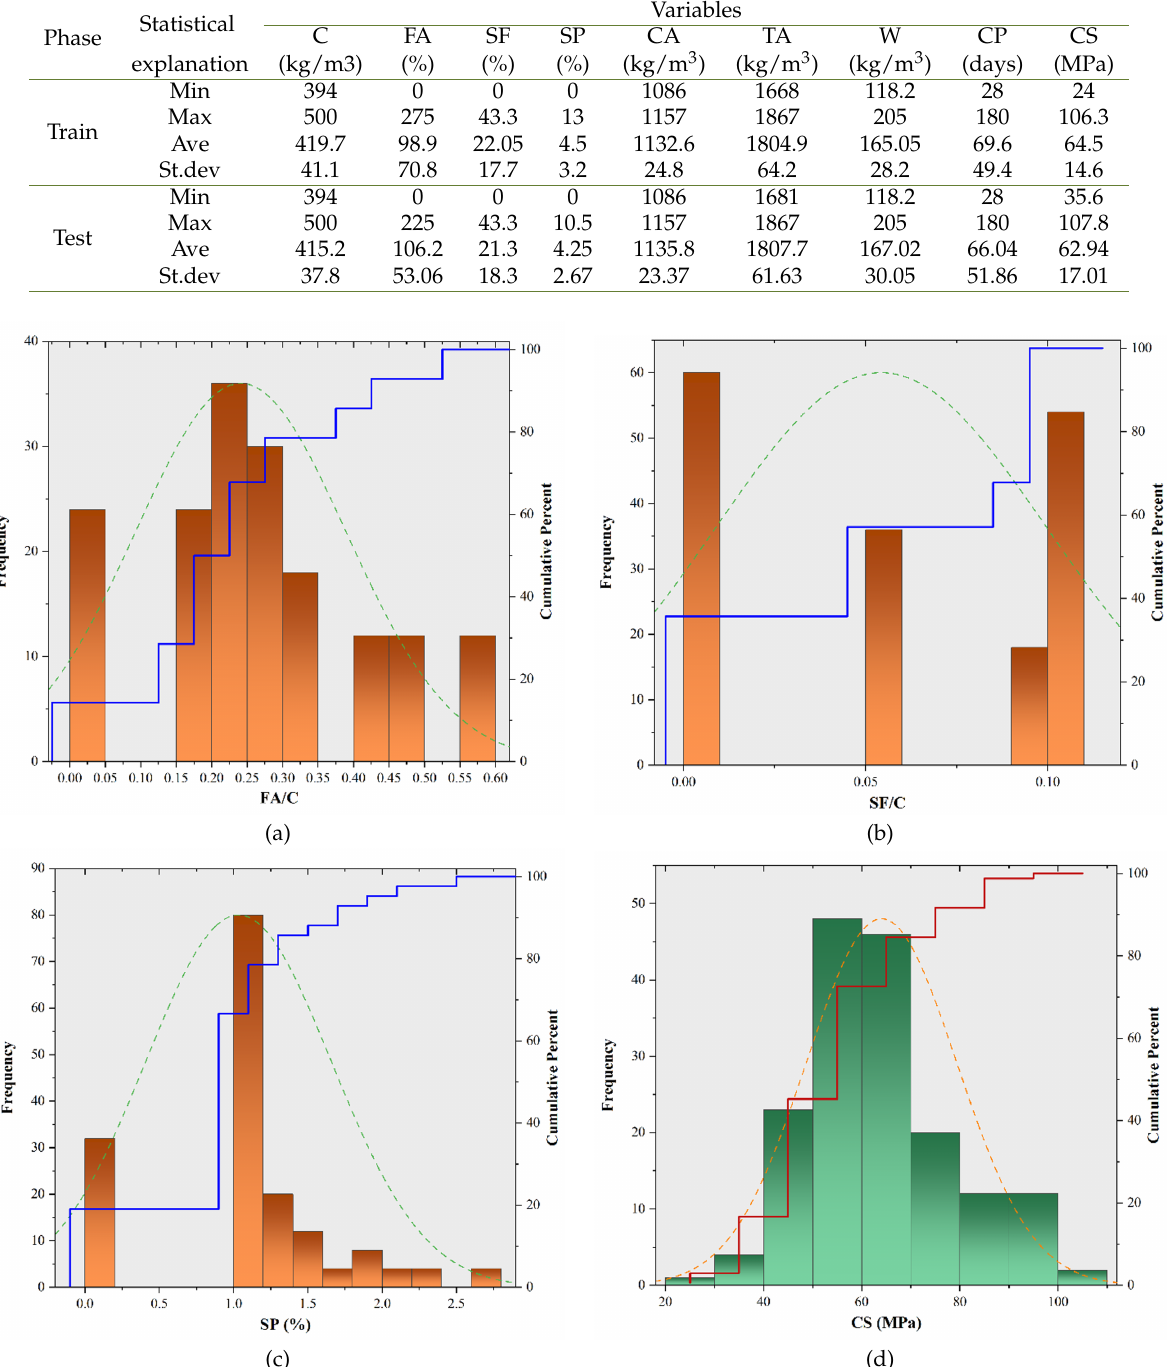
Table 1. Explanation of statistical properties of models intake data